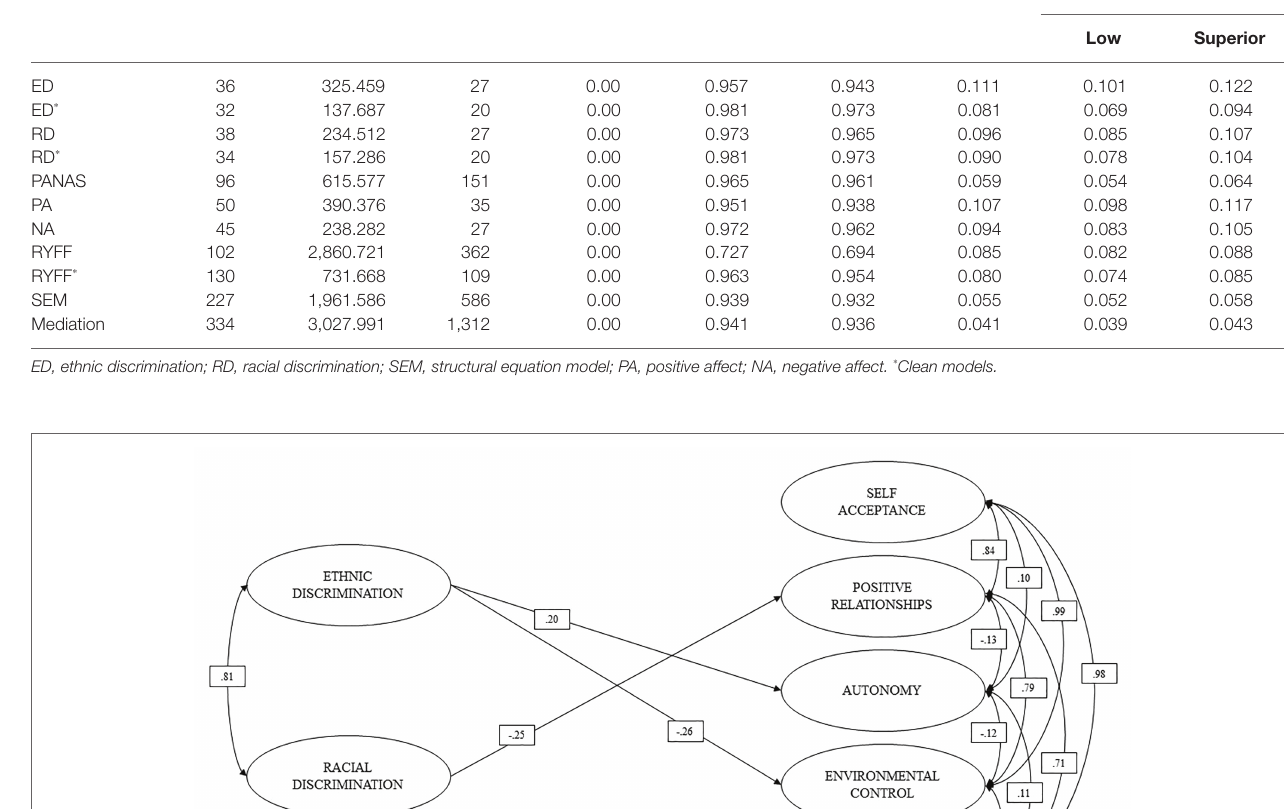
TABLE 2 | Indicators of global fit of the measurement models and the multiple mediation model. Models Parameters